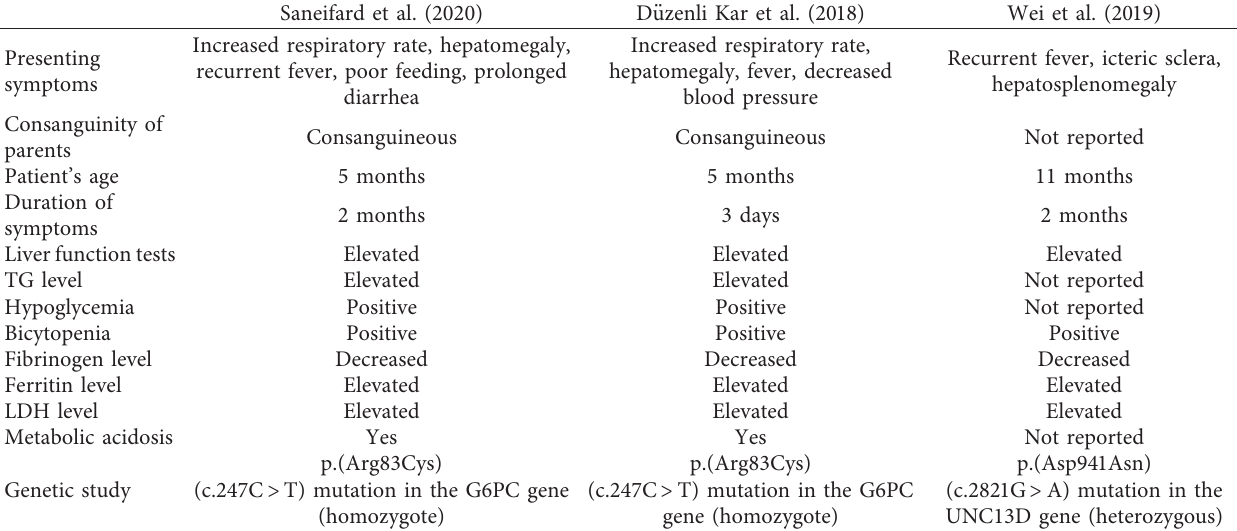
Table 4: Comparison of patient characteristics from previous reported